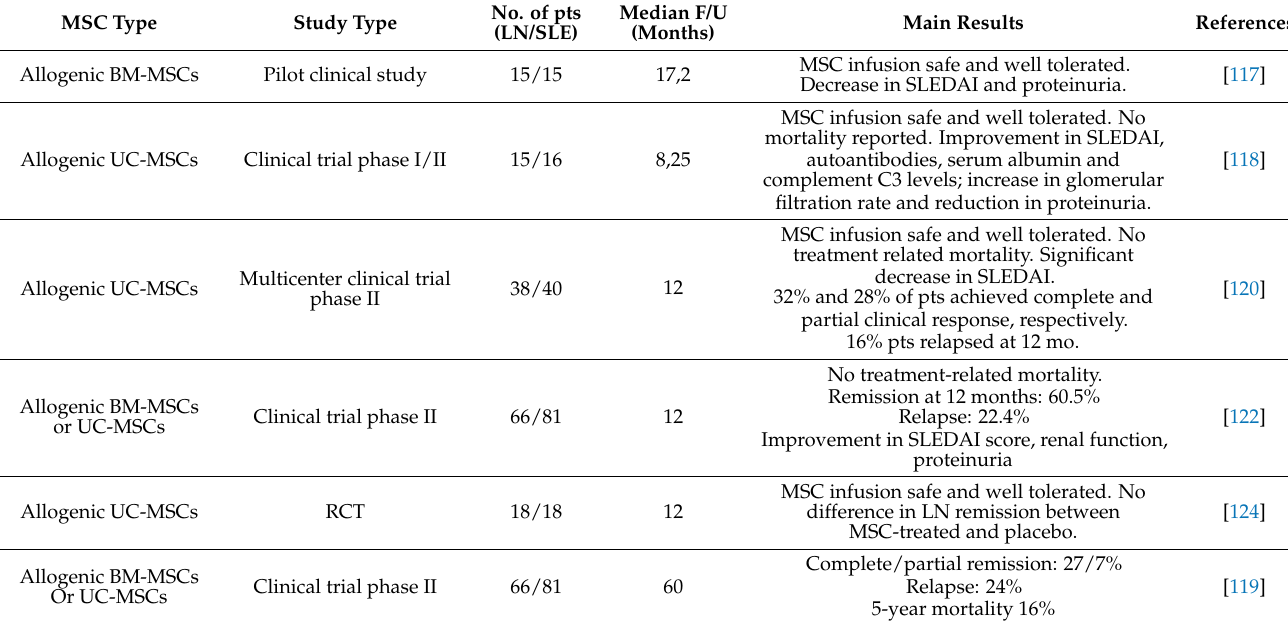
Table 2. Main clinical trials of MSC therapy in